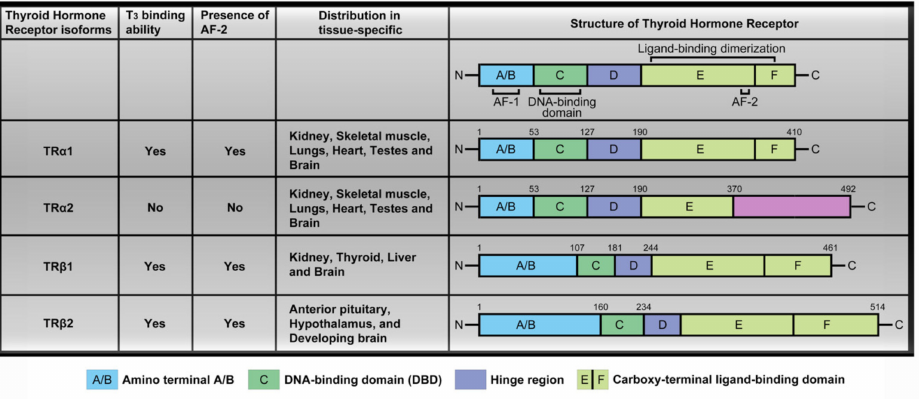
Figure 1. TR isoforms and structure distribution. Thyroid hormone receptors (TR) contain several domains, specifically, the amino terminal A / B that may function as a gene enhancer, the DNA-binding domain (DBD), the hinge region containing the nuclear localization signal and the carboxy-terminal ligand-binding domain that binds T 3 . The four major TR isoforms are TR α 1, TR α 2, TR β 1, and TR β 2. TH binding is widely distributed in a tissue-specific manner such as TR α 1 and TR α 2 expressed in the kidney, skeletal muscle, lungs, heart, and testes, with particularly high levels detected in the brain. TR β 1 expression is significant in the brain, thyroid, liver, and kidney while the TR β 2 isoform is specifically expressed in the anterior pituitary, hypothalamus, and developing